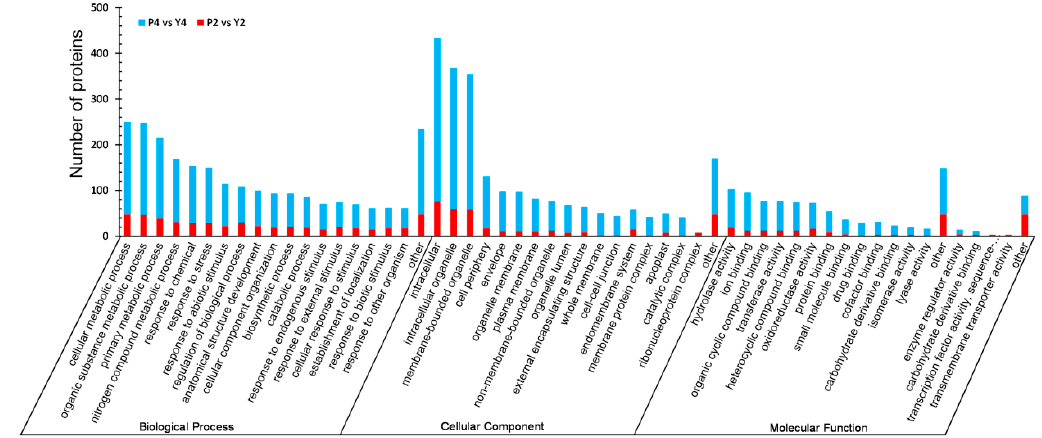
Figure 6. Statistical distribution chart of DEPs under each GO category (2nd level). The x ‐ axis represents GO term and the y ‐ axis displays the number of DEPs in each main category.